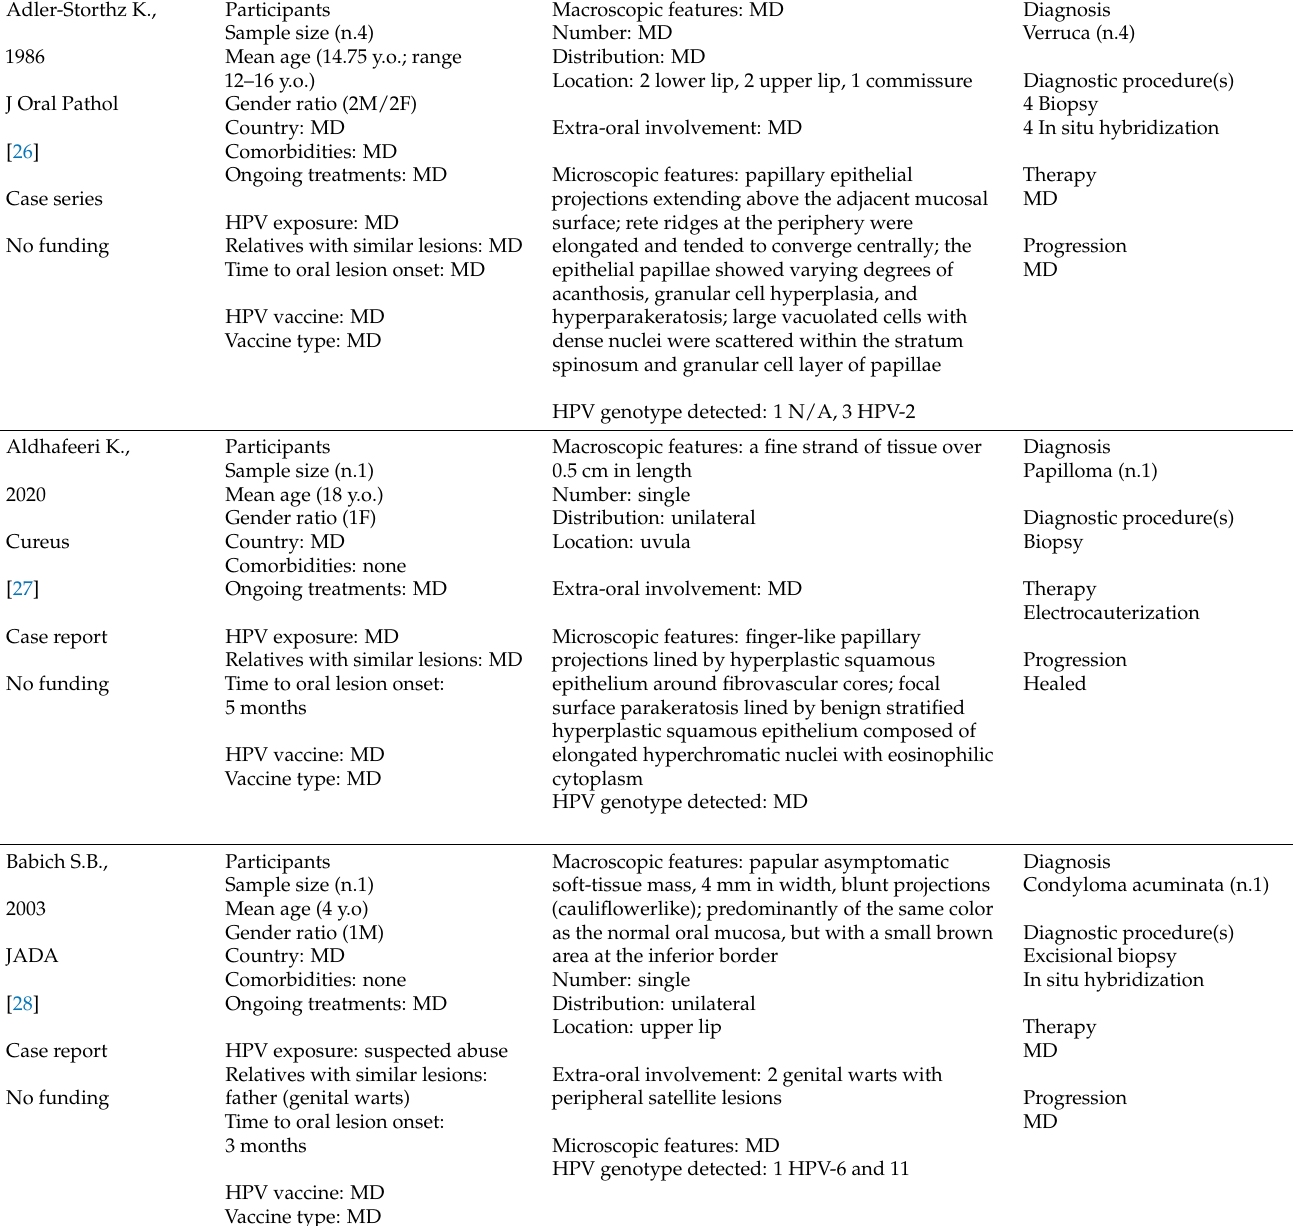
Table 1. Data extracted and collected from studies reporting pediatric cases diagnosed with oral papilloma, verruca vulgaris, or condyloma acuminata. Study characteristics: first author, year, and journal of publication; study design; the reference number; funding. Study methods: sample size (n.), mean age (y.o.), gender ratio (M/F), country, comorbidities and associated ongoing treatments, relatives with similar lesions, HPV exposure (if any), time to onset of oral lesions, type of HPV vaccine administered (if any). Oral HPV-related lesions: macroscopic and microscopic features, number (single/multiple), distribution (unilateral/bilateral, asymmetric or symmetric), location, extra-oral involvement, HPV genotype. Diagnosis: definitive diagnosis, diagnostic procedure(s) performed, therapy,